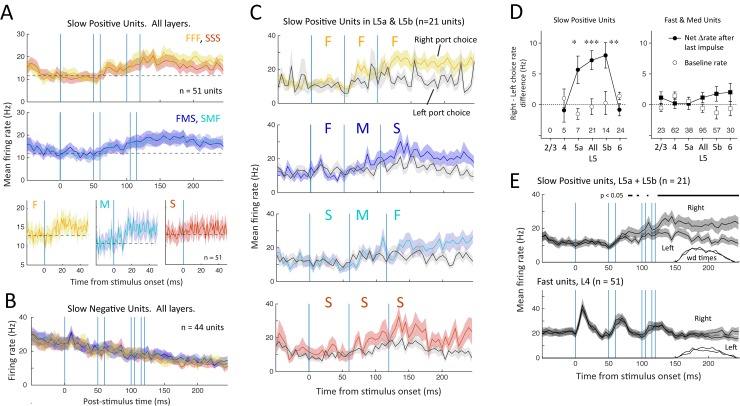
Choice coding by slow time scale units.(A) Top: population PSTH (mean ± SEM) for Slow Positive units across all layers. Responses were indistinguishable between FFF, FMS, SMF and SSS trains. Bottom: population PSTH for individual F, M, and S impulses, irrespective of sequence membership. (B) Population PSTH for slow negative units, showing lack of any impulse-evoked firing rate modulation. (C) Population PSTH for slow positive units in L5a and L5b, separated by stimulus type and drink port choice. Slow Positive units fired more on right-choice trials for all stimuli. (D) Difference in evoked rate between right- and left-choice trials, measured 5–50 ms after start of the final impulse, for all Slow Positive units (left) or Fast and Medium units (right). Number of units in each layer is shown at bottom. Open symbols, baseline rate before sequence onset for the same trials. * p = 0.022; ** p = 9.5 x 10-4; *** p = 7.5 x 10-5, paired t test comparing rate on right versus left choice trials. (E) Population PSTH averaged across all four sequences, for right- versus left-choice trials, for Slow Positive units in L5 (top), and for Fast units in L4 (bottom). Bar shows times when rate is significantly different between right- and left-choice trials by sliding t test (p < 0.05). The distribution of nose poke withdrawal times is shown for the same trials. Data for this figure are at crcns.org repository (accession ssc-4).